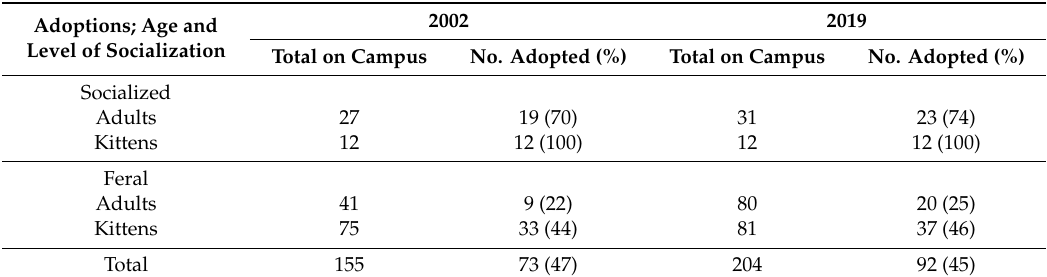
Table 3. Adoptions at the end of the initial observation and combined observation periods. Adoptions; Age and Level of